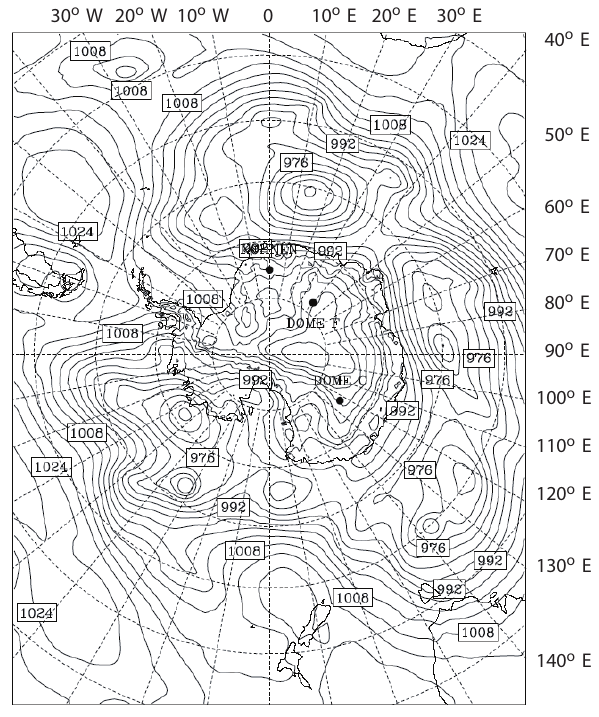
Figure 5. Sea level pressure from AMPS (domain 1) for 3 May 2007, 00:00UTC.